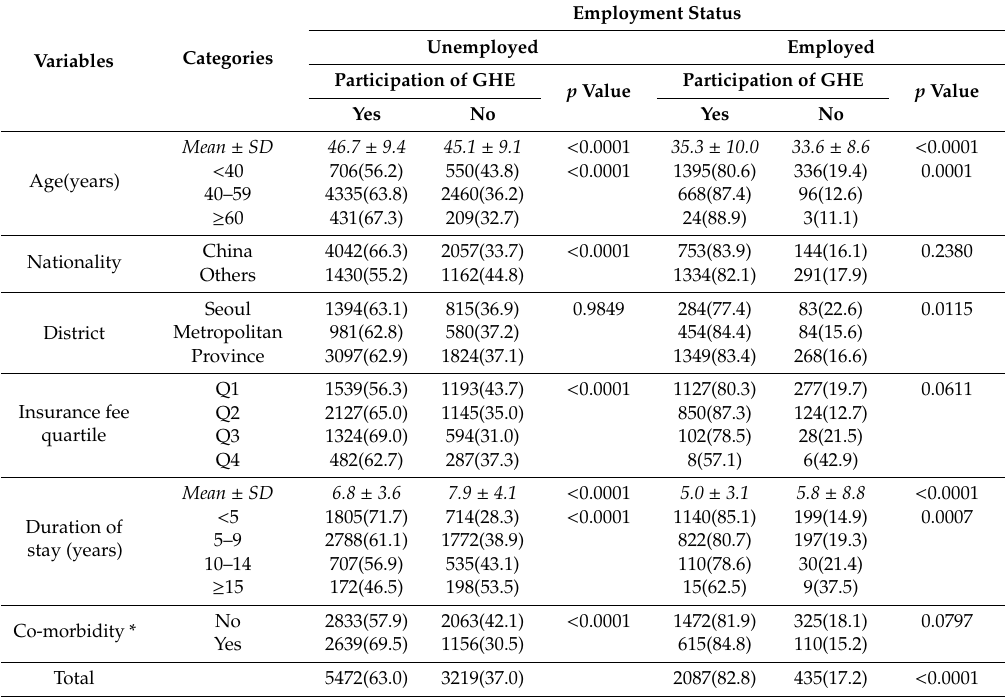
Table 2. Participation in General Health Examinations among married immigrant females in Korea by employment status.